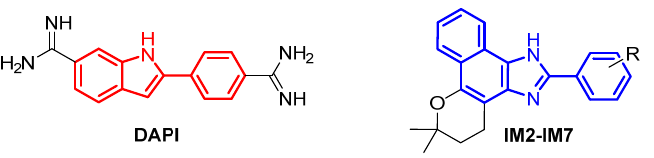
Figure 3. Structural similarity of DAPI and synthesized naphth[1,2 ‐ d ]imidazoles.